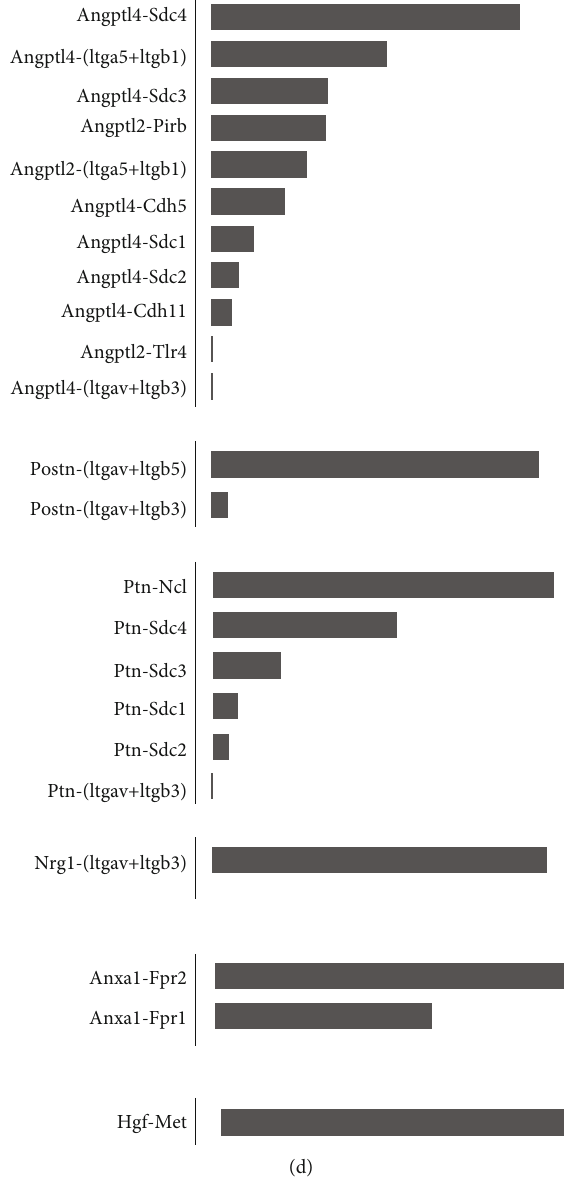
Figure 5: CellChat inference of signaling pathways among BLM + ADSCs group. (a) UMAP distribution of coarsely annotated cell type of both lung-originated cells and with recollected ADSCs (ADSC_rec) in BLM + ADSCs group. (b) Stacked violin plot of Ptprpc (CD45), CD68, and Egfp expression in BLM + ADSCs group. (c, d) Signaling pathway network in BLM + ADSC group calculated by CellChat. showing signaling between recollected ADSCs (ADSC_rec) and lung-originated cells. (c) Sender, receiver, mediator, and in fl uencer of di ff erent pathways. (d) Relative contribution of each ligand-receptor pair in corresponding pathway